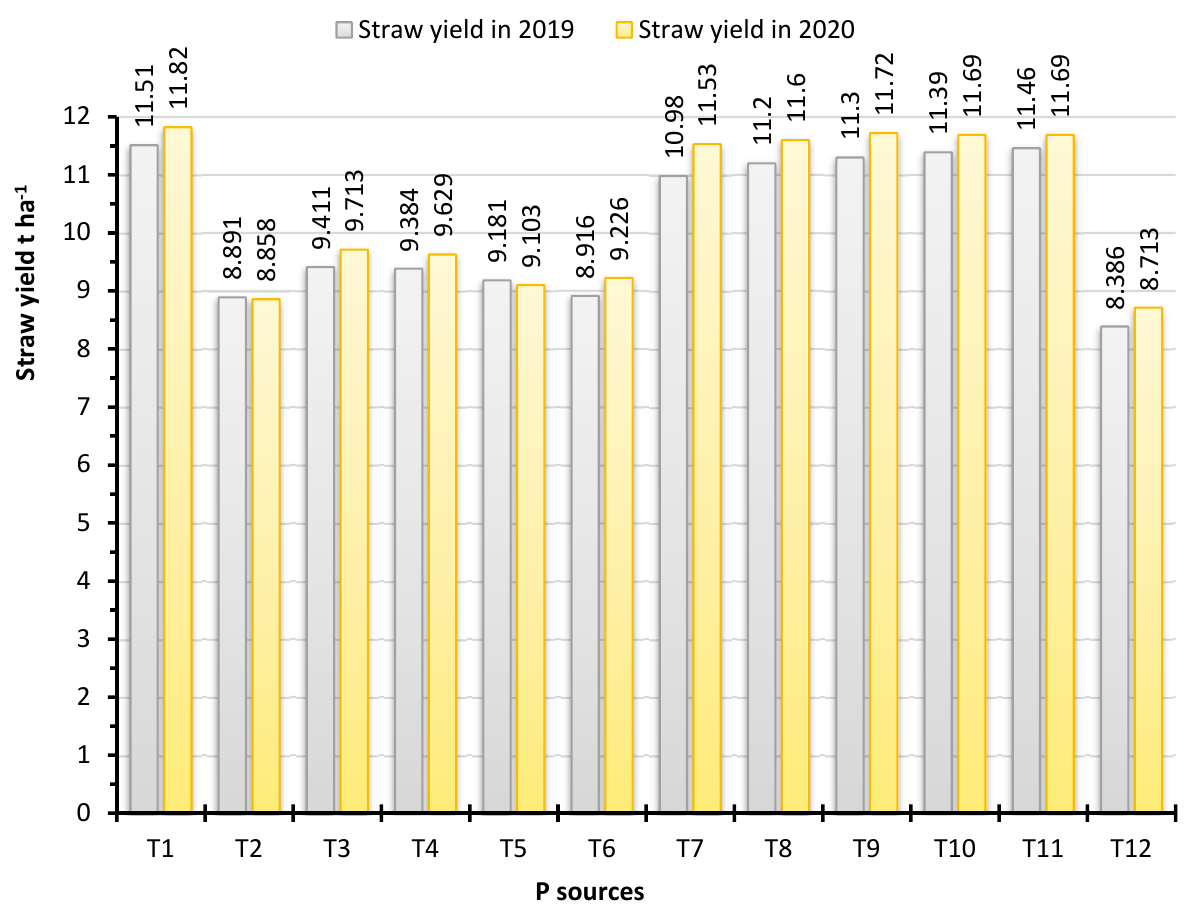
Figure 6. Straw yield of Sakha 106 rice cultivar was affected by arbuscular mycorrhizal fungi, phosphate-solubilizing bacteria and selected chemical phosphorus fertilizers in the 2019 and 2020 seasons. SSP, single super phosphate (15% P 2 O 5 ); PSBs, phosphate-solubilizing bacteria; AMFs, arbuscular mycorrhizal fungi; PNPs, phosphorus nanoparticles; PA, phosphoric acid. T1, basal application of 100% single super phosphate (SSP) (P 1 ); T2, basal application of 75% SSP (P 2 ); T3, P 2 + top-dressing with phosphate-solubilizing